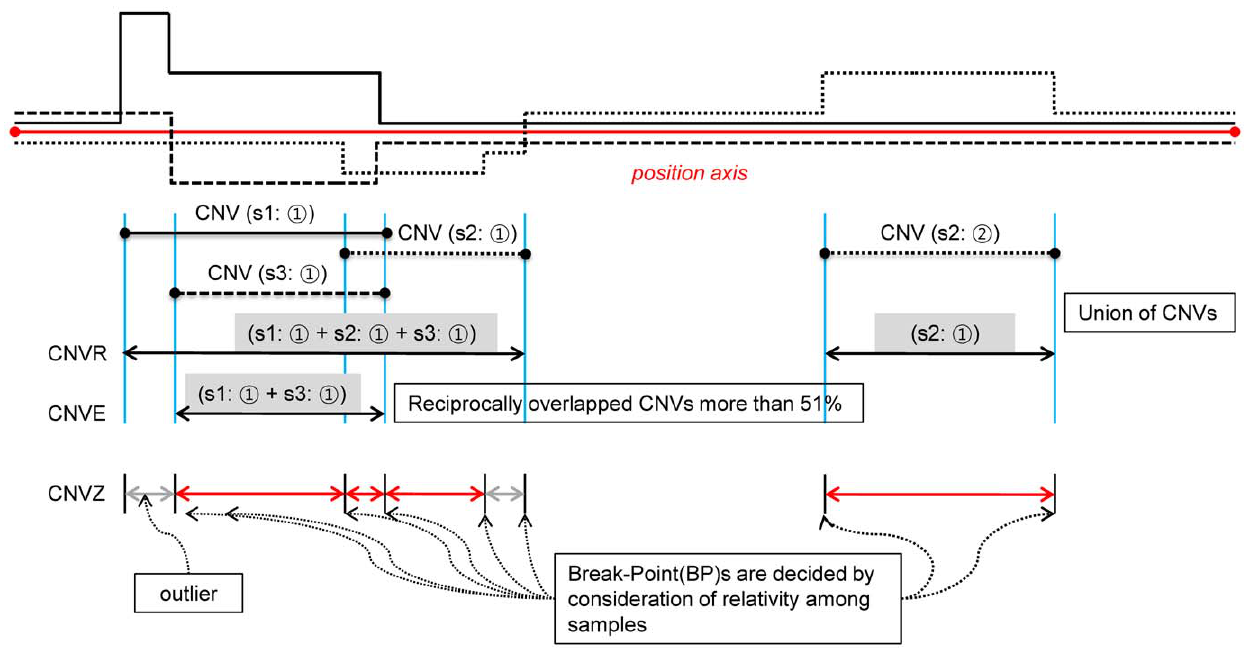
Figure 1. The conceptual difference between CNVR, CNVE, and CNVZ. For three samples, the early methods detected all of the CNVs for three samples individually. The CNVR or CNVE were determined after the CNVs were detected. The CNVR is the union of overlapping CNVs [20] and a CNVE exists if the CNVs reciprocally overlap by more than 51% [23]. In this Figure, ‘‘CNV (s2: q )’’ represents the second CNV of sample 2. The CNVZ is not built from individual CNVs. The start and end positions of the CNVZ are determined by the breakpoint (BP) of the segment, which is identified from the consistency of all the samples. We defined a CNVZ as a locus where the consistency of the log ratio across all of the samples was broken and where samples that were highly positive or negative were